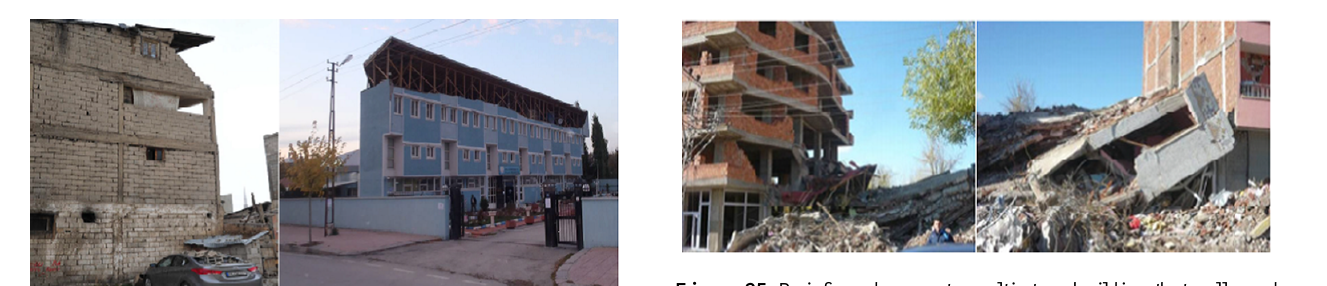
Figure 25. Reinforced concrete multi-story building that collapsed by colliding with adjacent buildings due to a hammering effect (Inel et al., 2011).